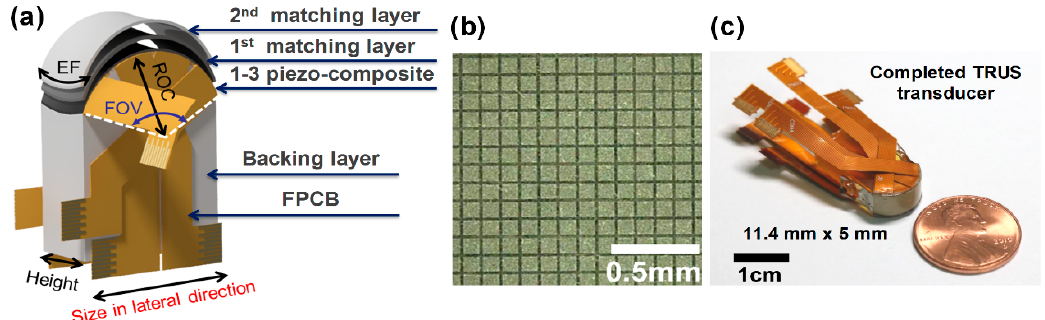
Figure 4. ( a ) Description of acoustic structure of the developed TRUS probe, ( b ) photograph of the finished 1–3 piezocom- posite, and ( c ) photograph of the finished TRUS probe. Reprinted with modification from Reference [24].